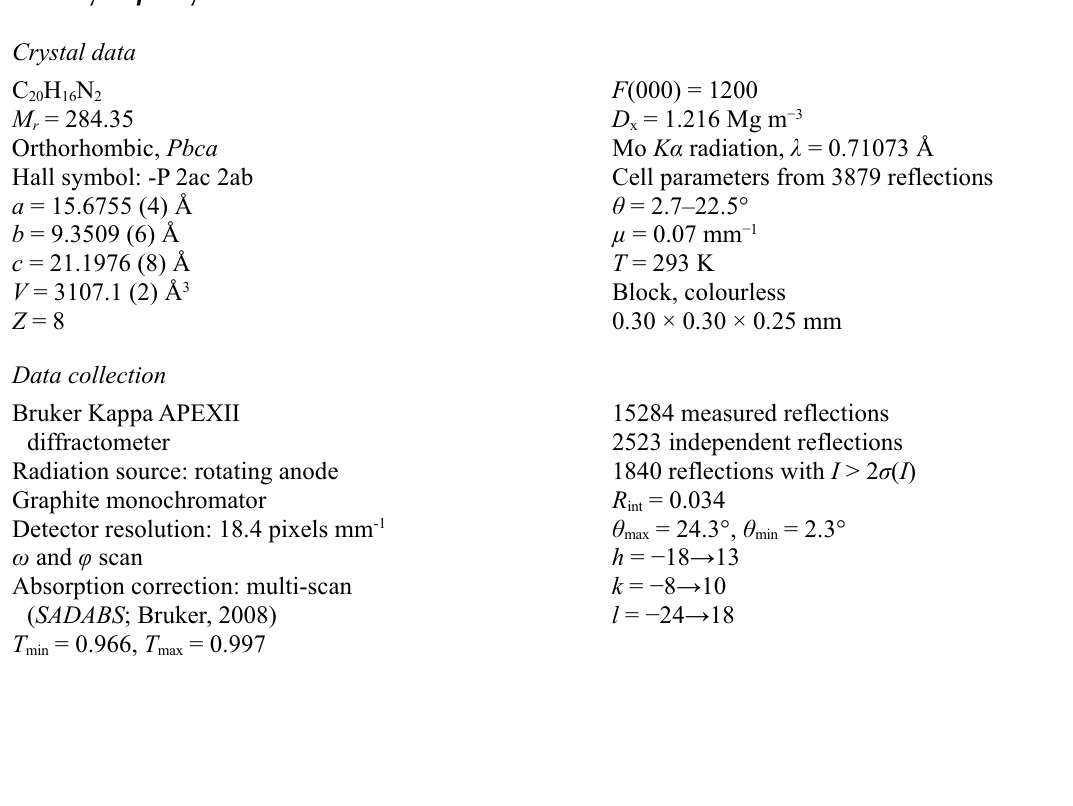
Figure 2 Packing diagram of (I). Dashed lines indicate intermolecular hydrogen bonding interactions. 1-Phenyl-2- p -tolyl-1 H